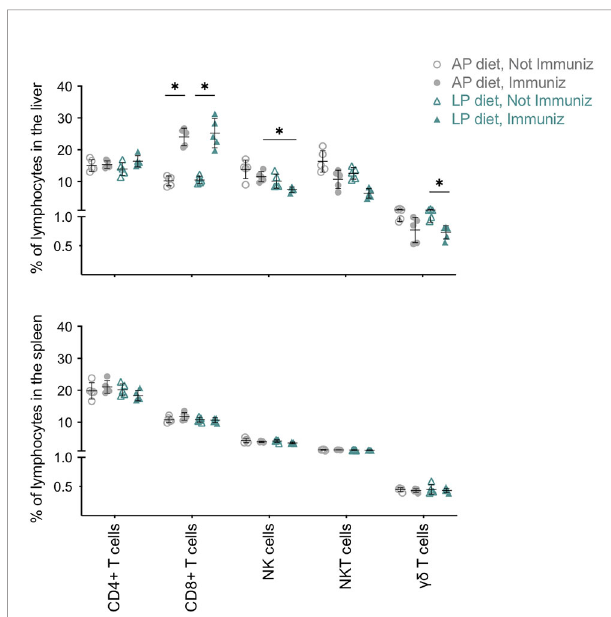
FIGURE 3 | Impact of low protein diet during RAS immunization on the immune populations of the liver and spleen. Frequency of CD4+ T, CD8+ T, NKT, gd T and NK cells in the liver and spleen of non-immunized or RAS- immunized mice under AP or LP diet on the day of infection/challenge (day 35). Data are presented as mean ± SD and were compared using the Kruskal-Wallis test with Dunn ’ s multiple comparison post-test, with selection of the following pairs: AP diet Not Immunized (NImm) vs. AP diet Immuniz (Imm), LP diet NImm vs. LP diet Imm, AP diet NImm vs. LP diet NImm and AP diet Imm vs. LP diet Imm (*P <